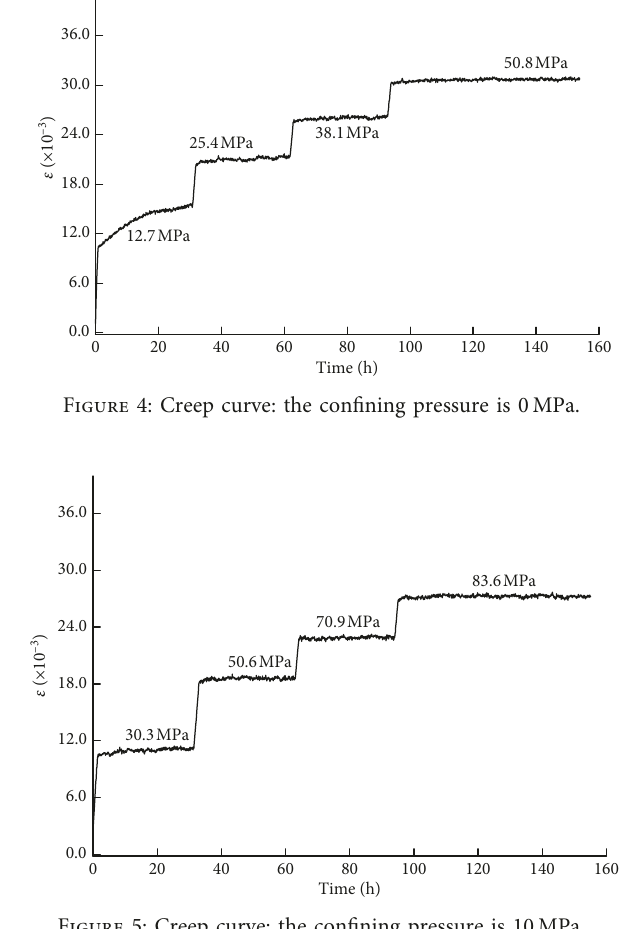
Figure 5: Creep curve: the confining pressure is 10MPa.